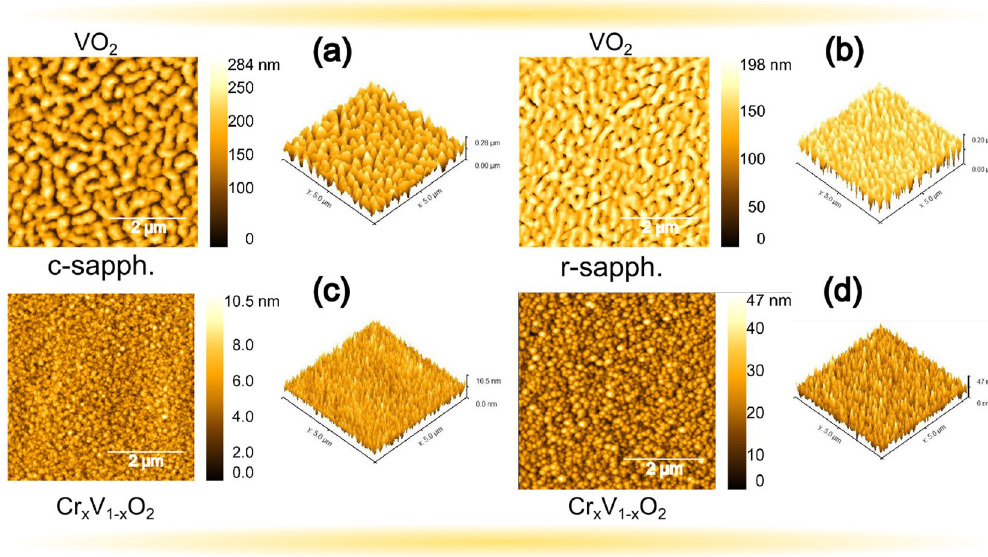
Figure 3. AFM surface morphology of 140 nm-thick undoped ( a , b ) and Cr-doped ( c , d ) VO 2 films on c- and r-plane sapphire